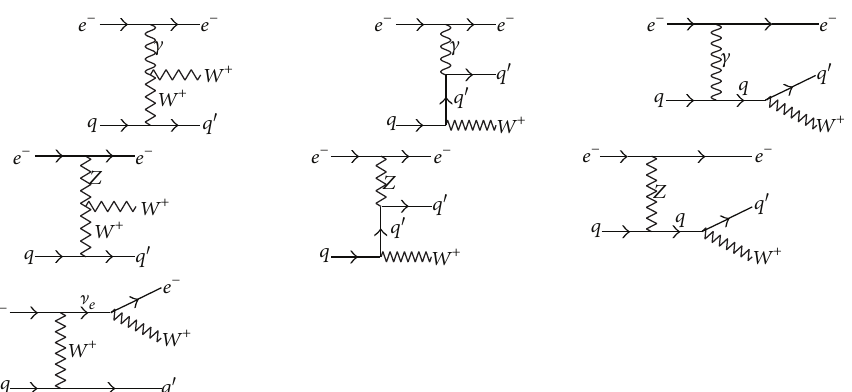
Figure 4: Feynman diagrams for the SM background process 𝑒 − 𝑞 → 𝑒 − 𝑊 + 𝑞 󸀠 .